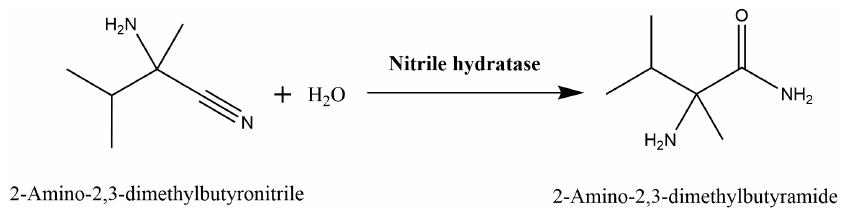
Figure 1. Hydration of racemic 2-amino-2, 3-dimethylbutyronitrile (ADBN) catalyzed by NHase.